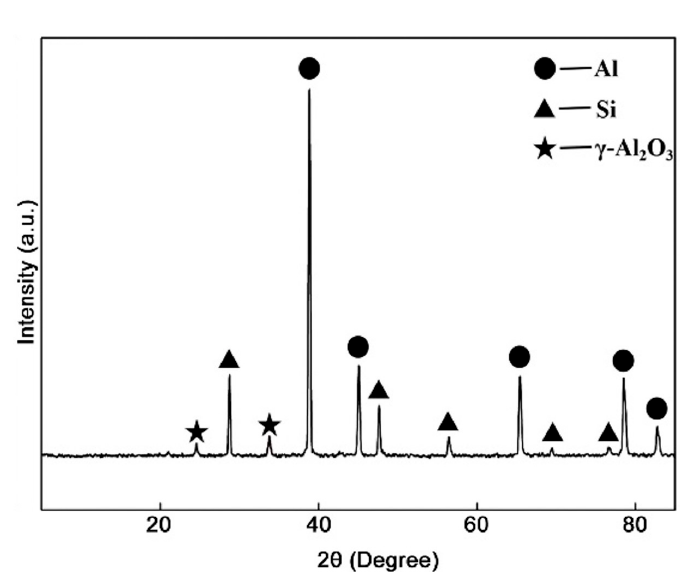
Figure 3. XRD pa tt ern of Al–20Si@Al 2 O 3 powder. Figure 3. XRD pattern of Al–20Si@Al 2 O 3